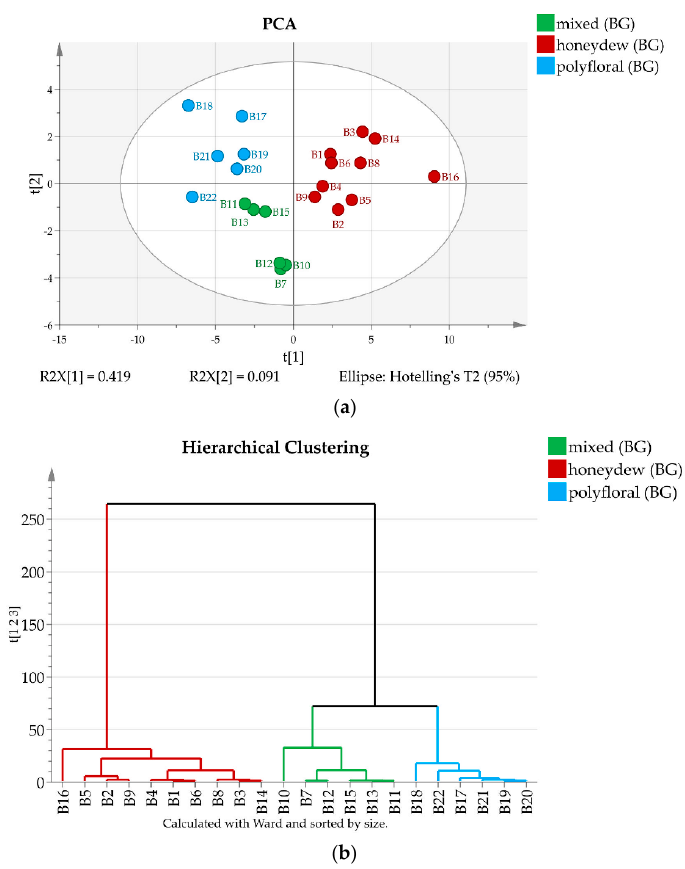
Figure 3. ( a ) 2D score PCA plot of Bulgarian honey samples using quantities of all components; ( b ) Dendrogram of Bulgarian honey samples.